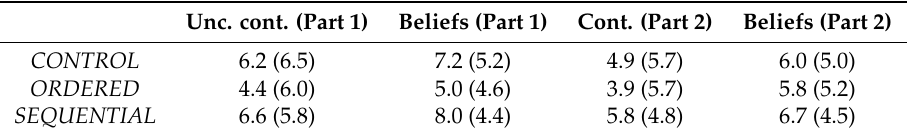
Table A1. Mean beliefs and contributions across parts and treatments (standard deviations in